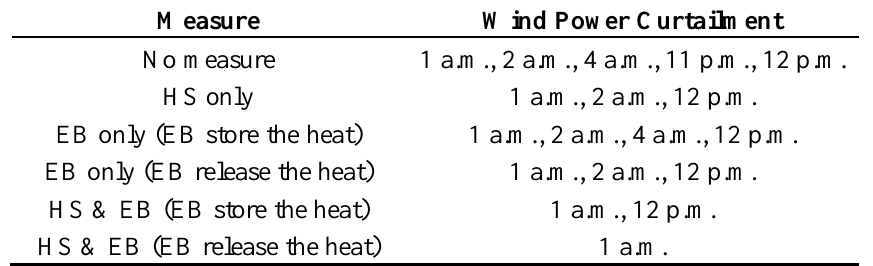
Figure 5. A sketch map of reverse peak regulation characteristics of wind power. Table 1. The effects of different operating mode of thermal-electric decoupling (TED) on wind power